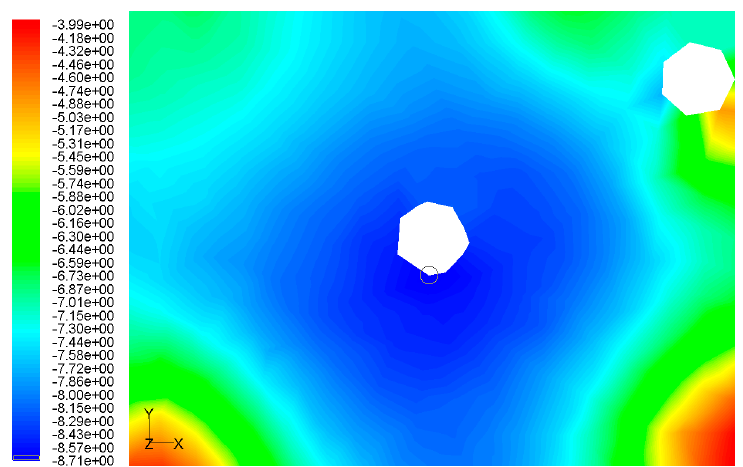
Figure 7. Pressure contour 10 m from the heading face (Pa).